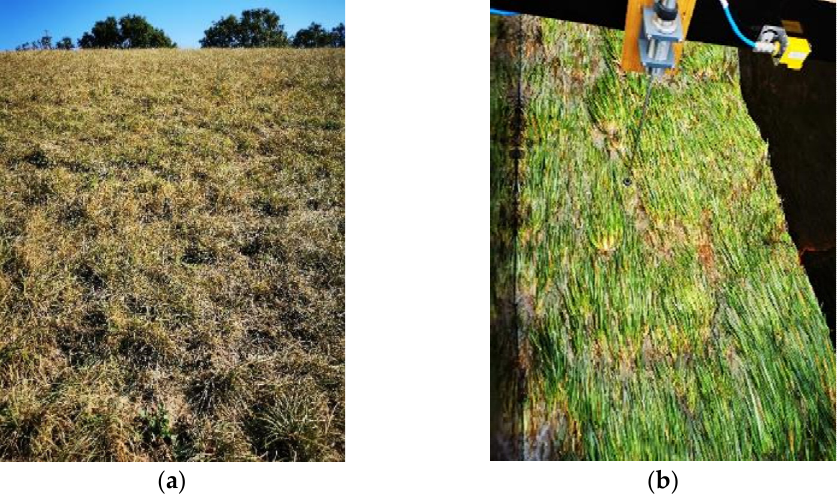
Figure 7. ( a ) Belgian reference test section (September 2020); ( b ) Typical view of exposed grass roots after multiple hours of overflow.